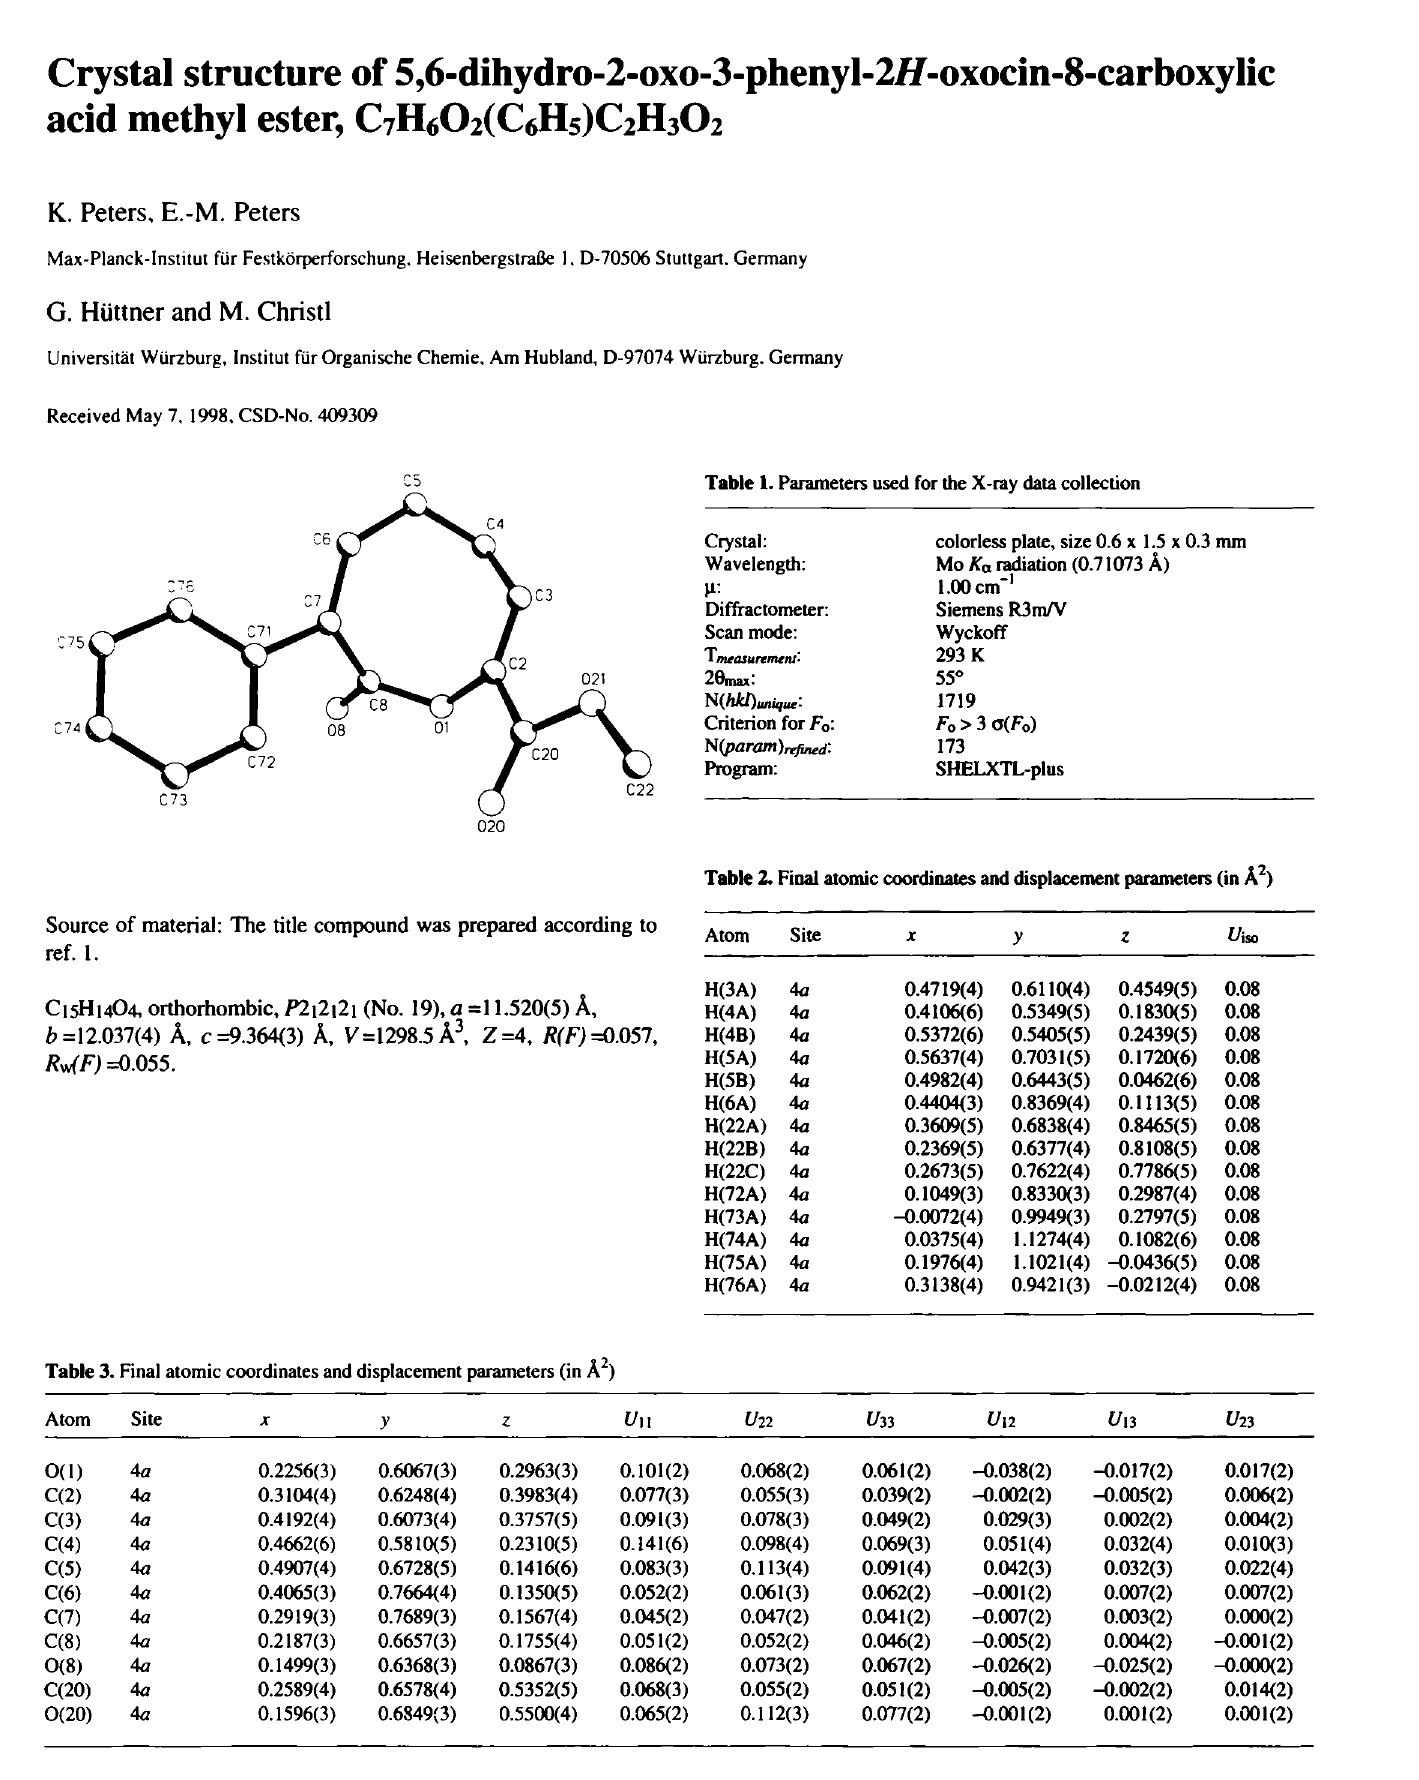
Table 1. Parameters used for the X-ray data collection